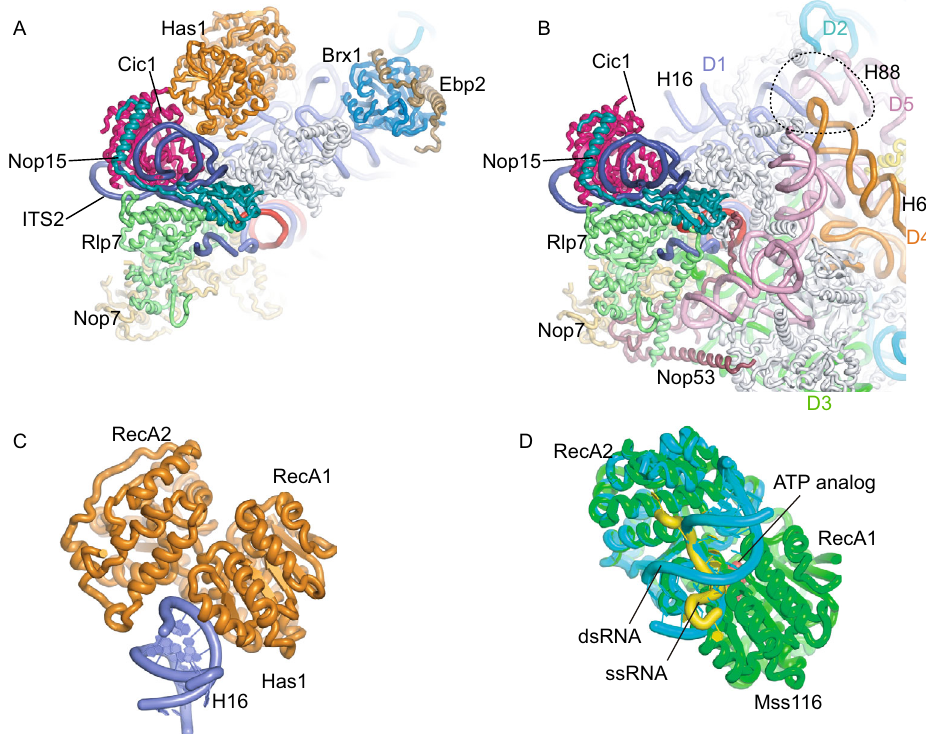
Figure 3. AFs bound to ITS2 and domain I. (A) Structure of Rpf1-TAP pre-60S near the ITS2. AFs, ITS2, 5.8S and individual domains of 25S rRNAs are color coded. All RPLs are shown in gray. (B) Structure of the Nog1-TAP pre-60S (PDB code: 3JCT) shown in the same view as (A). The dashed circle indicates the binding site of Brx1 and Ebp2 that would clash with H68 and H88. (C) Structure of Has1 bound to H16. (D) Superimposed structures of Mss116 in complex with ssRNA and dsRNA. Mss116 is aligned to Has1 in (C) by the RecA1 domain. The ternary complex structure (PDB code: 3I5X) is composed of Mss116 (green), ssRNA (yellow) and ATP analog (red). The binary complex containing the RecA2 domain of Mss116 bound to an RNA duplex (PDB code: 4DB2) is colored cyan and aligned to the ternary